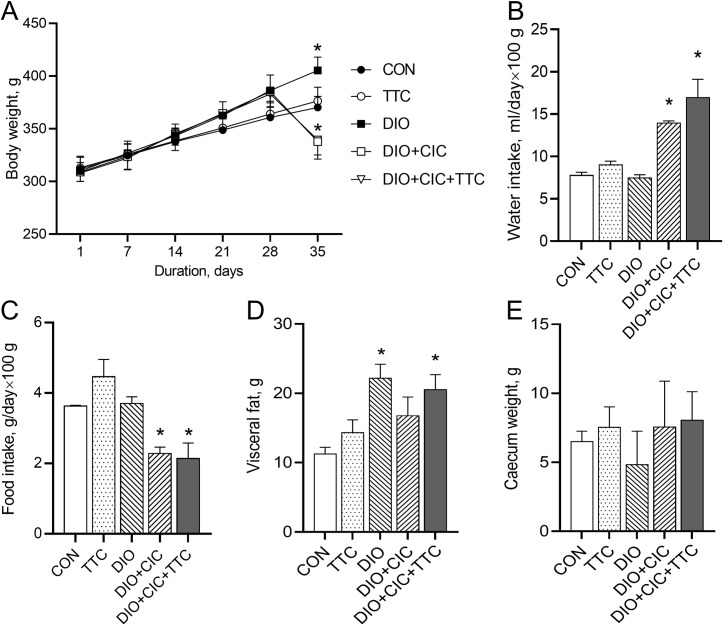
Effects of different treatment regimens on animal body weight, food and water intake, and the weights of visceral fat and the cecum.(A) Weekly changes in body weight, (B) water and (C) food intake, and (D) visceral fat and (E) cecum weights. Data are expressed as mean ± SD. * indicates p < 0.05 when data is compared to that for the CON group.